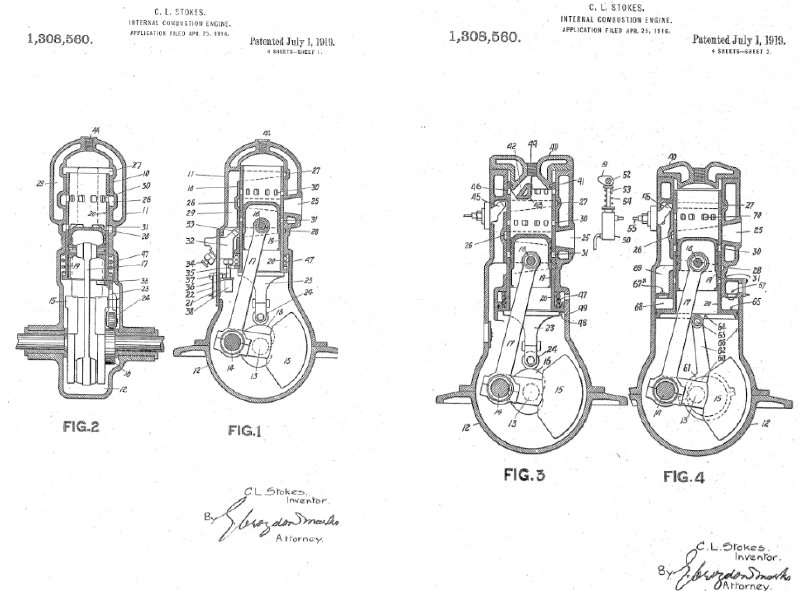
Figure 6. C.L Stokes, 2 April 1916, internal combustion engine US 1308560. Reproduced with per-